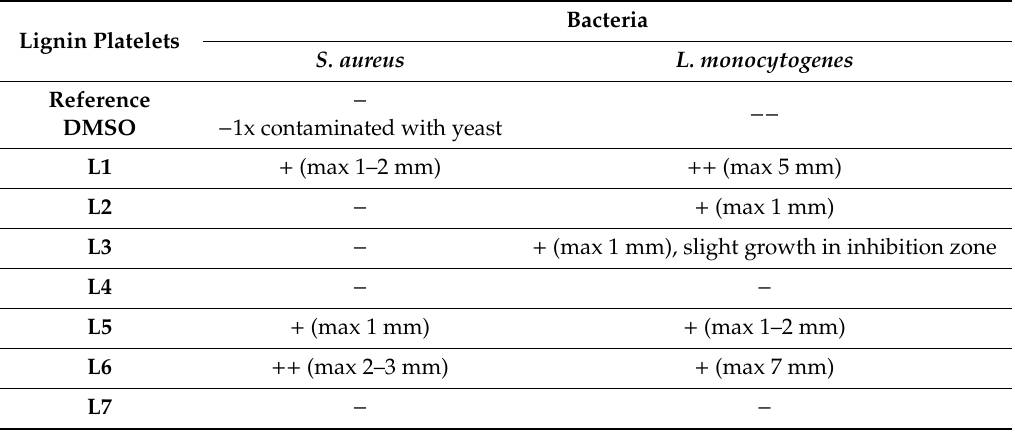
Table 1. Inhibition zones of lignin samples against S. aureus, L. monocytogenes , and E. coli obtained by disk di ff usion method.